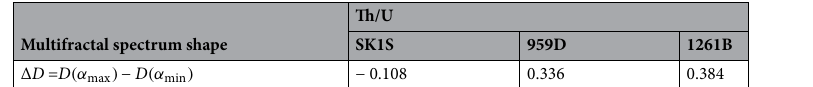
Multifractal spectrum shape